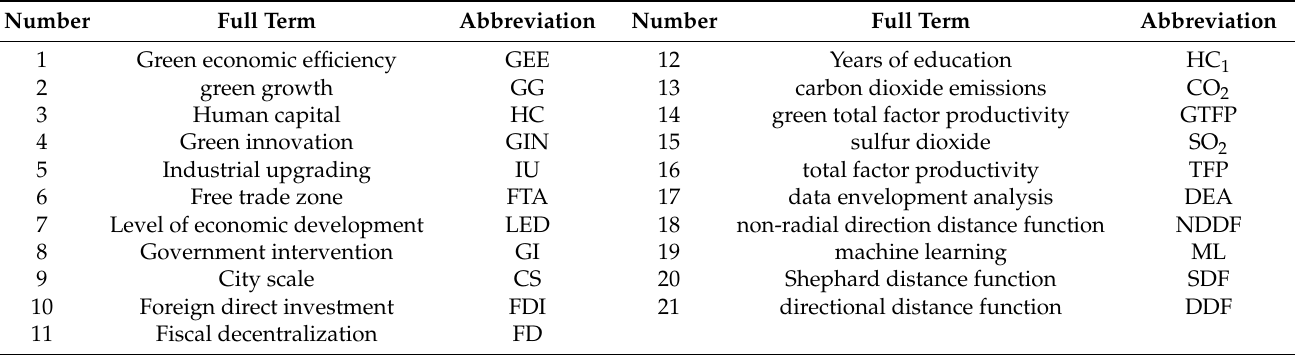
Table A1. Full term and the abbreviations.